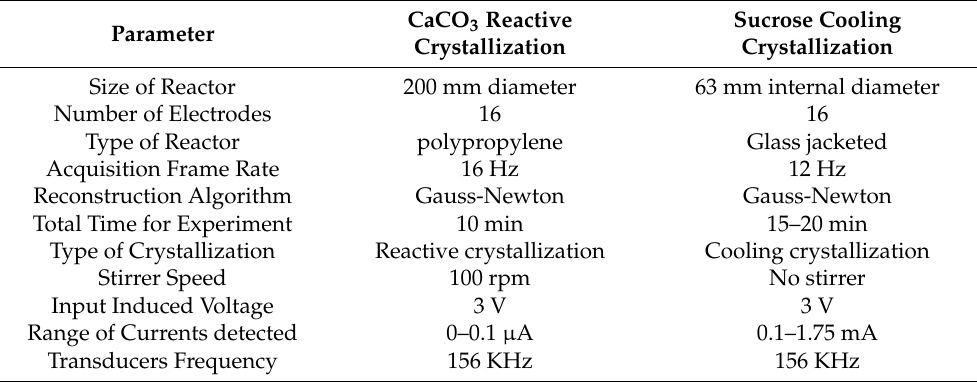
Table 2. Case studies and experimental configuration to demonstrate the application of ERT-Vis software in different crystallization